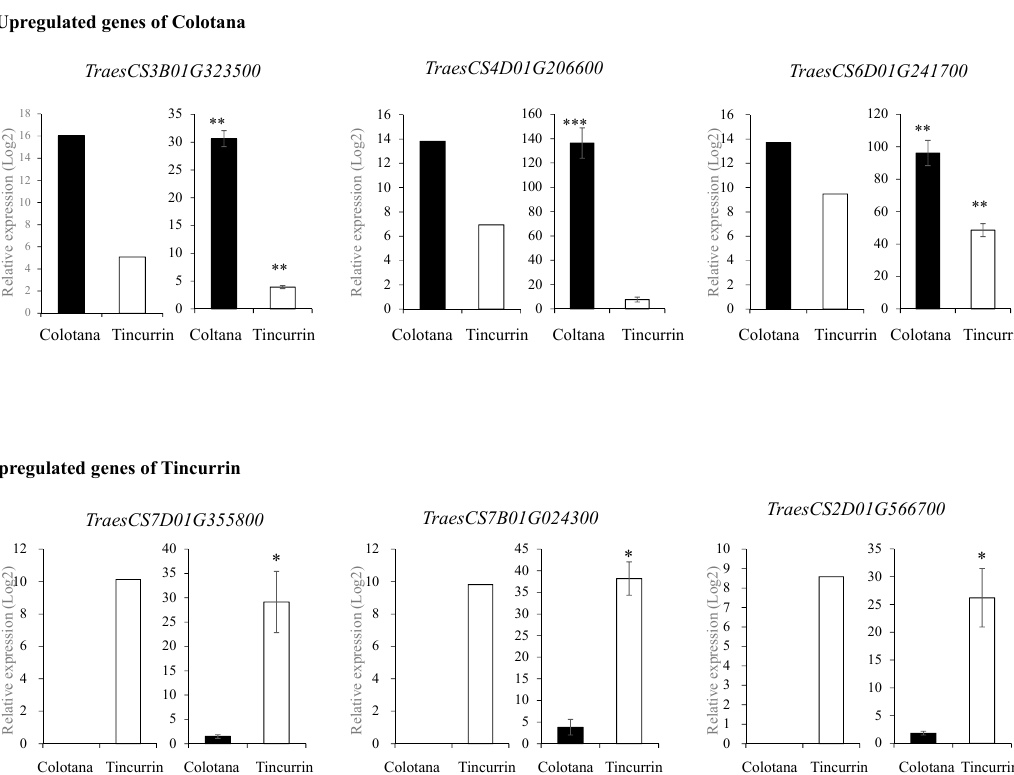
Figure 2. qRT-PCR validation of up- and downregulated DEGs in Colotana and Tincurrin. RNA-seq results (left) and qRT-PCR results (right) for six genes. Values are means ± SD of three biological replicates in qRT-PCR. The expression levels of each gene are expressed as relative to the mean value of the control samples. Student’s t-test was used to assess the significance of differences from control samples, * p < 0.05, ** p < 0.01, *** p < 0.001.